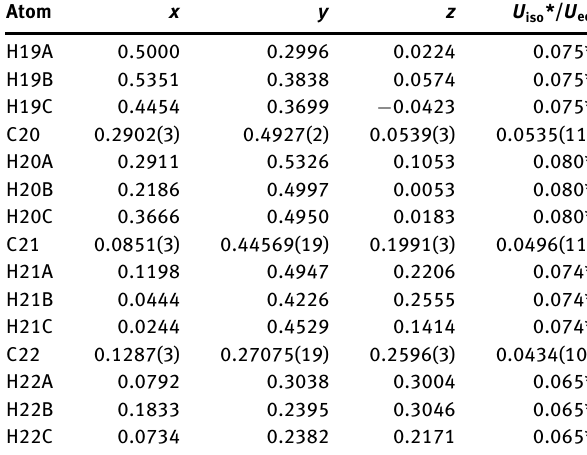
Table 2: Fractional atomic coordinates and isotropic or equivalent isotropic displacement parameters (Å 2